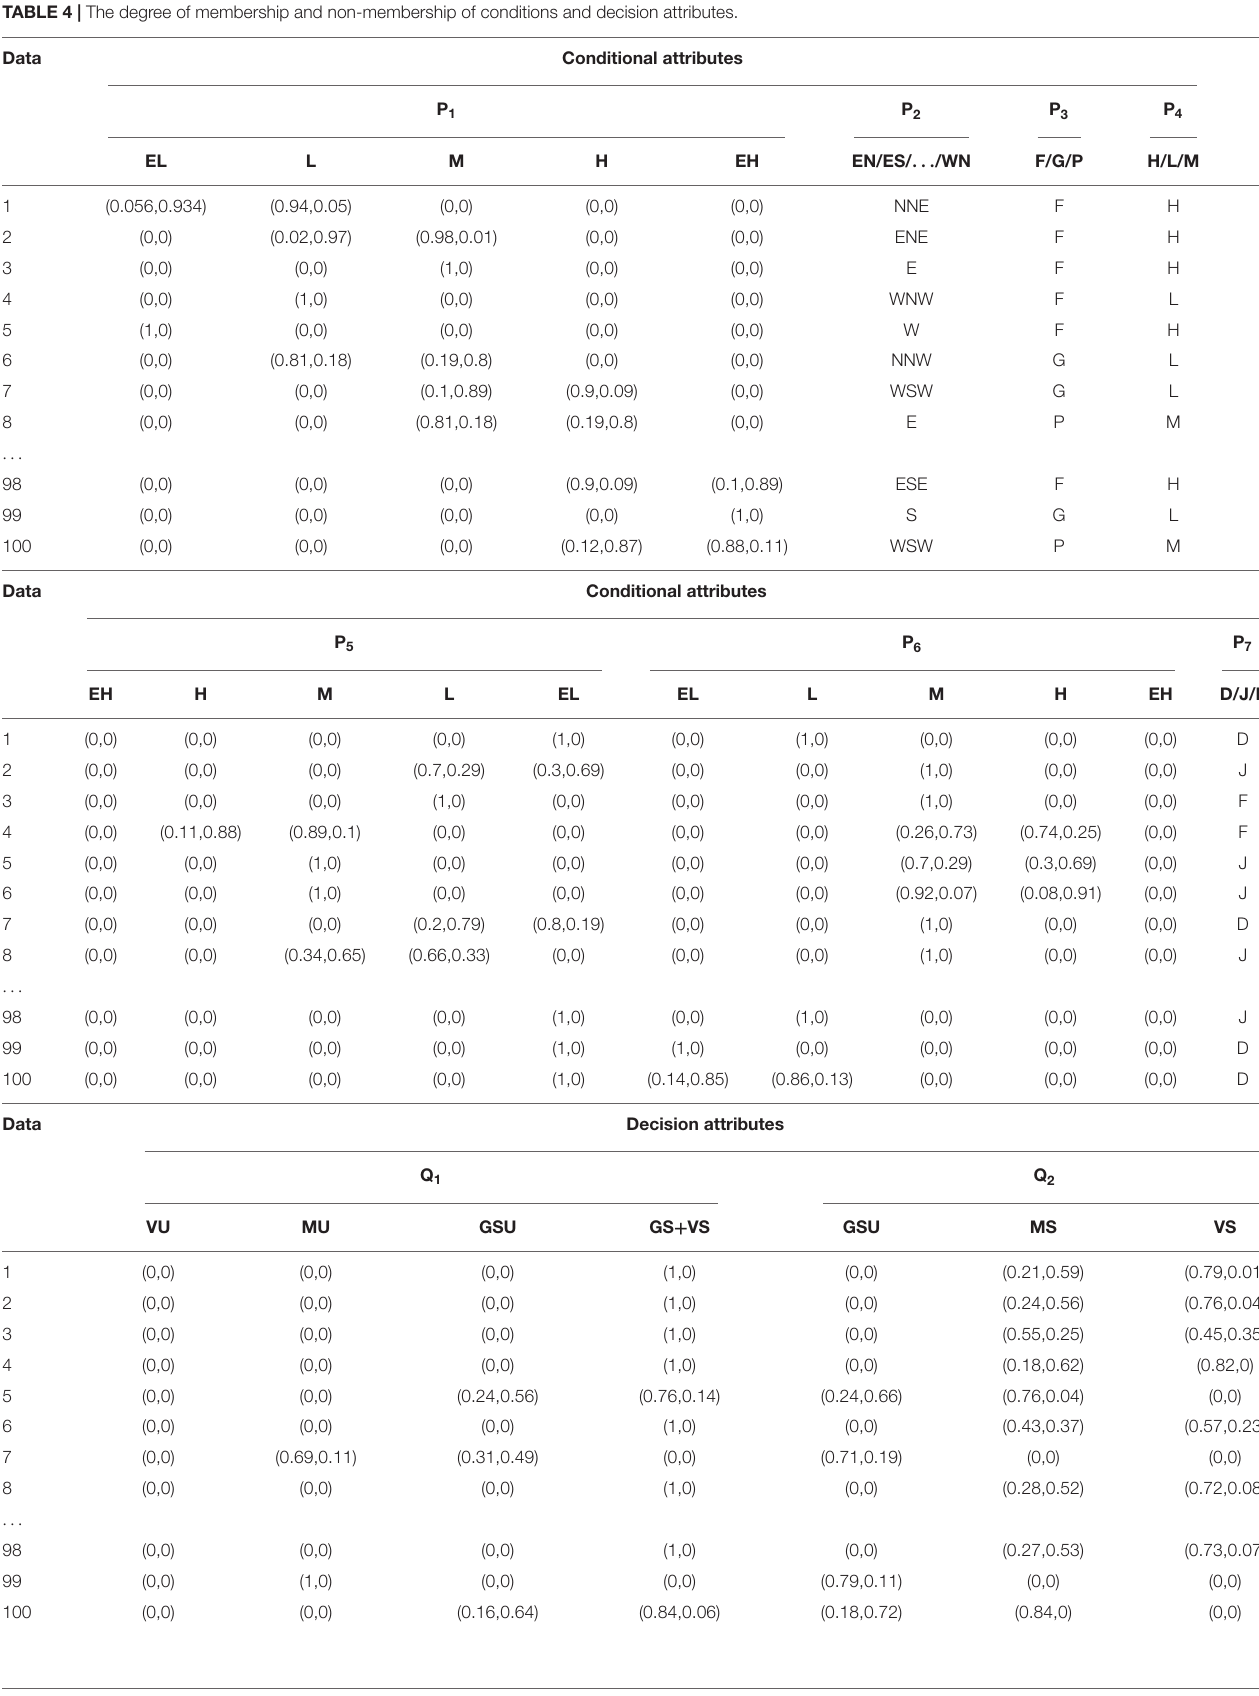
TABLE 4 | The degree of membership and non-membership of conditions and decision